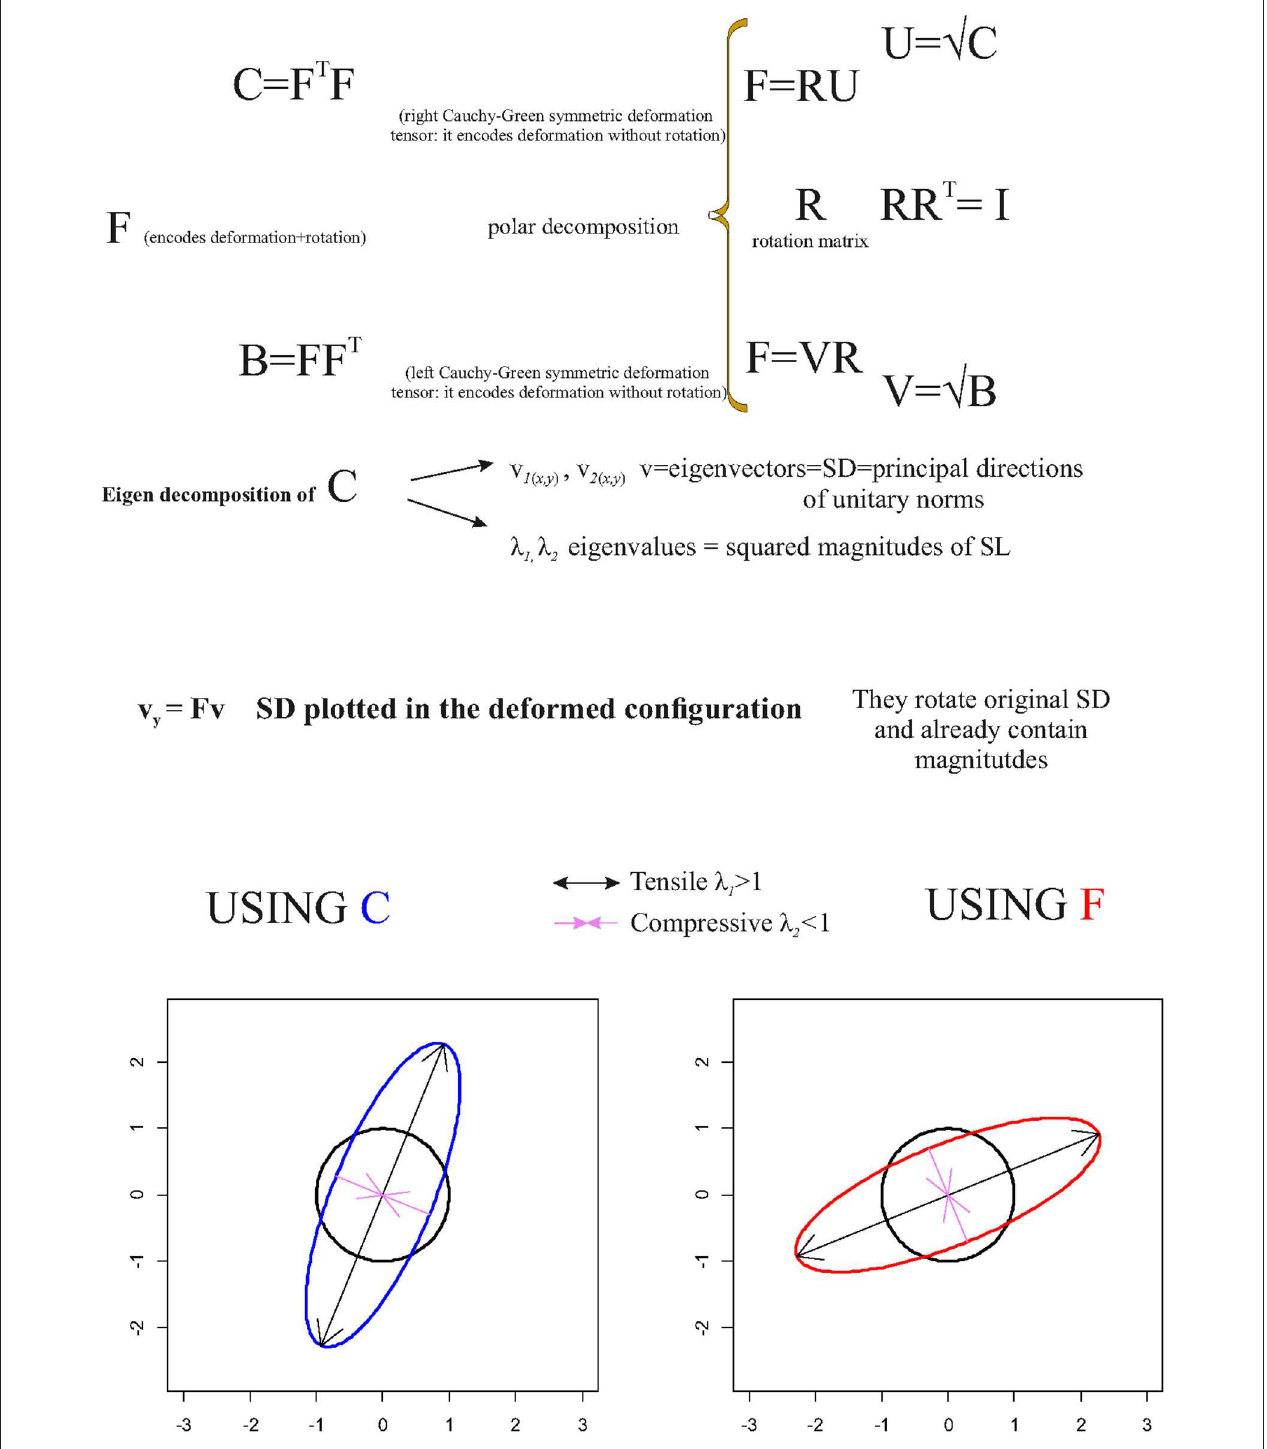
FIGURE 5 | Synthetic illustration showing the very basic mathematical relationship between F , C , and R as well as the geometrical meaning of v and v y .